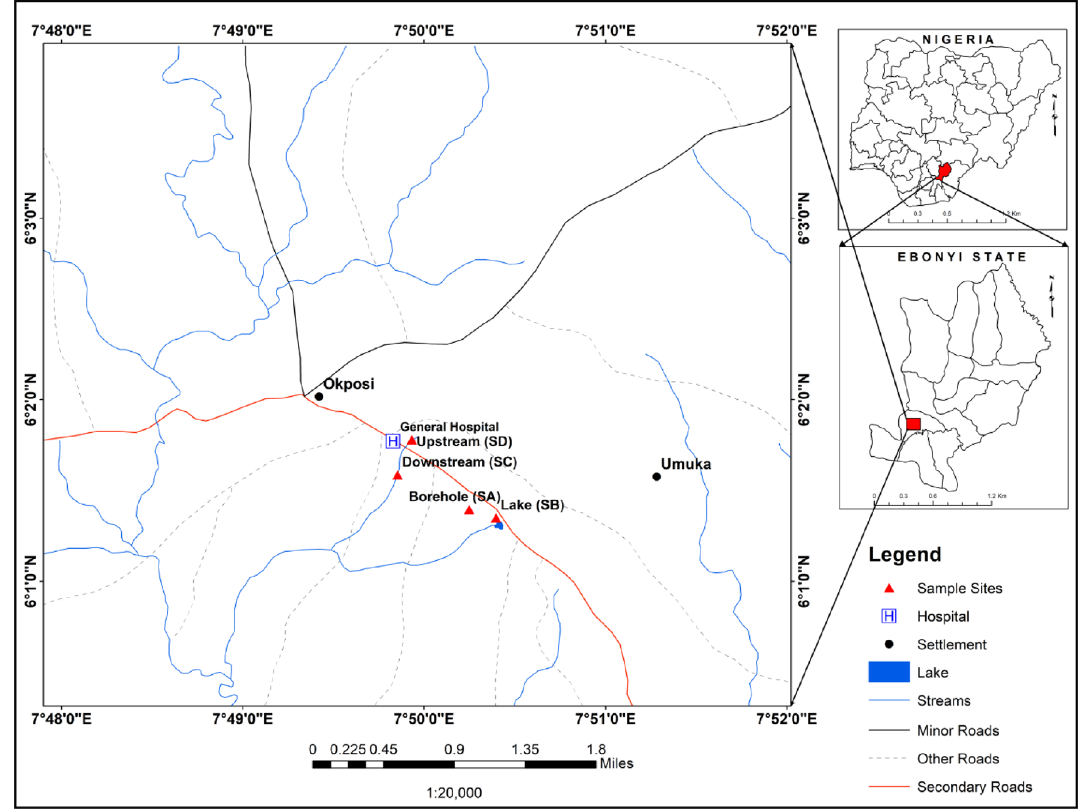
Fig. 1 Water sampling locations in Okposi, Ebonyi State,